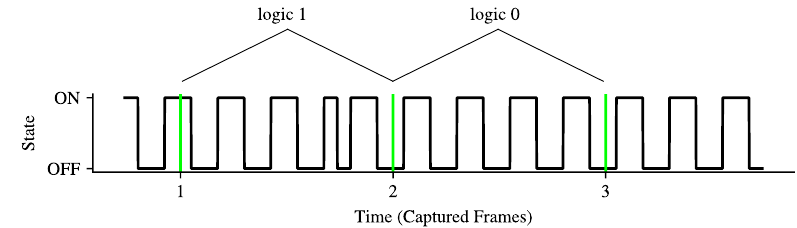
Figure 7. UDPSOOK in π /2 modulation mode.